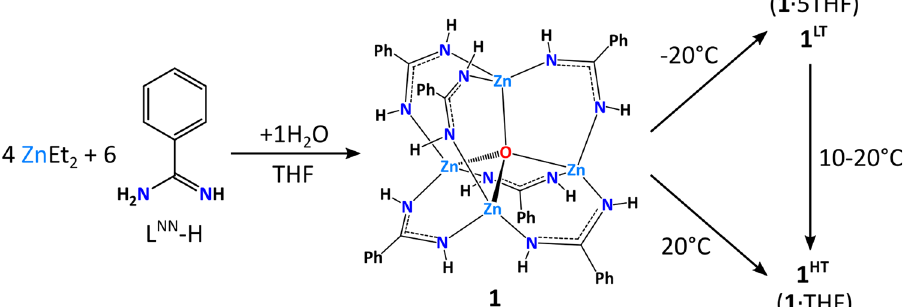
Fig. 2 Synthesis of zinc-oxo cluster 1. Schematic representation of the synthesis of zinc-oxo cluster 1 and their transformations to the crystal phases 1 LT and 1 RT